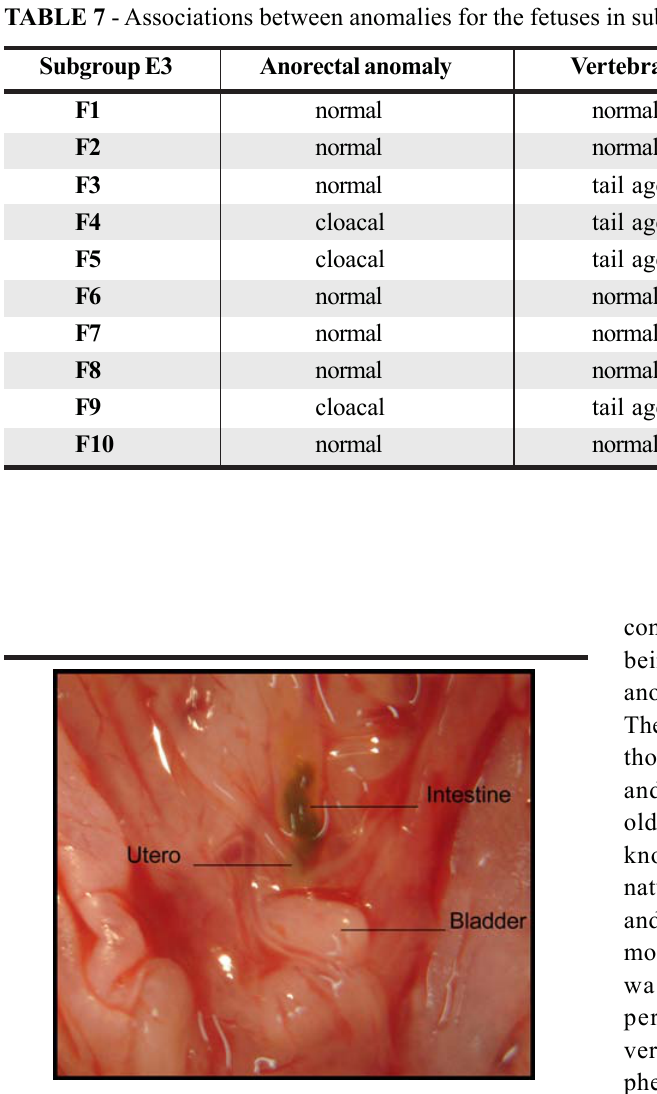
FIGURE 6 - Persistence of the